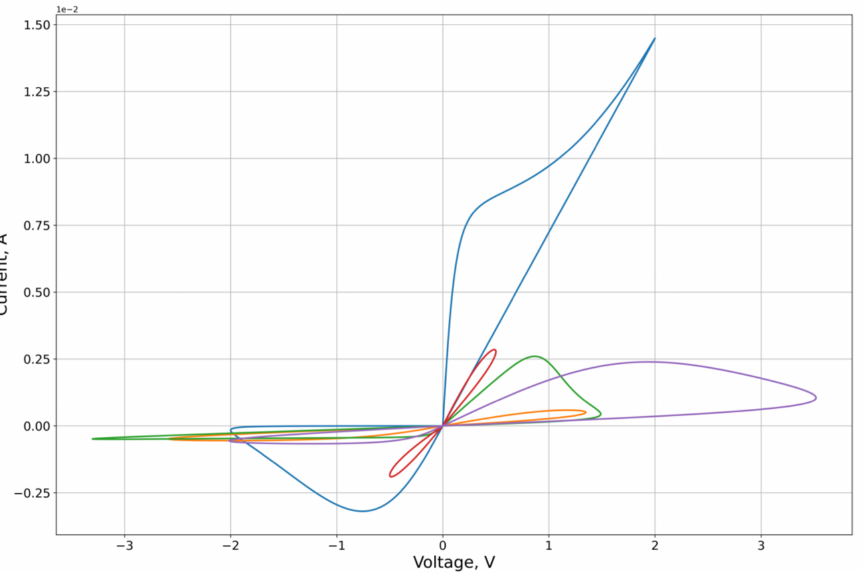
Figure 5. Results of the optimization of the right lobe of the synthetic sampling circuits (Figure 3) by the Shi’s